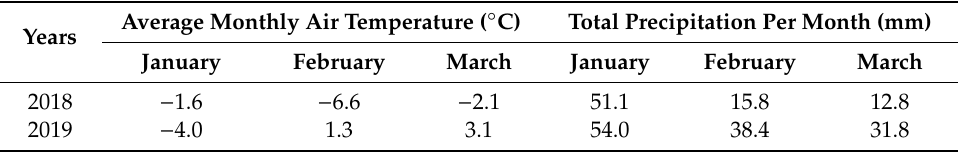
Table 1. Meteorological conditions in January–March of